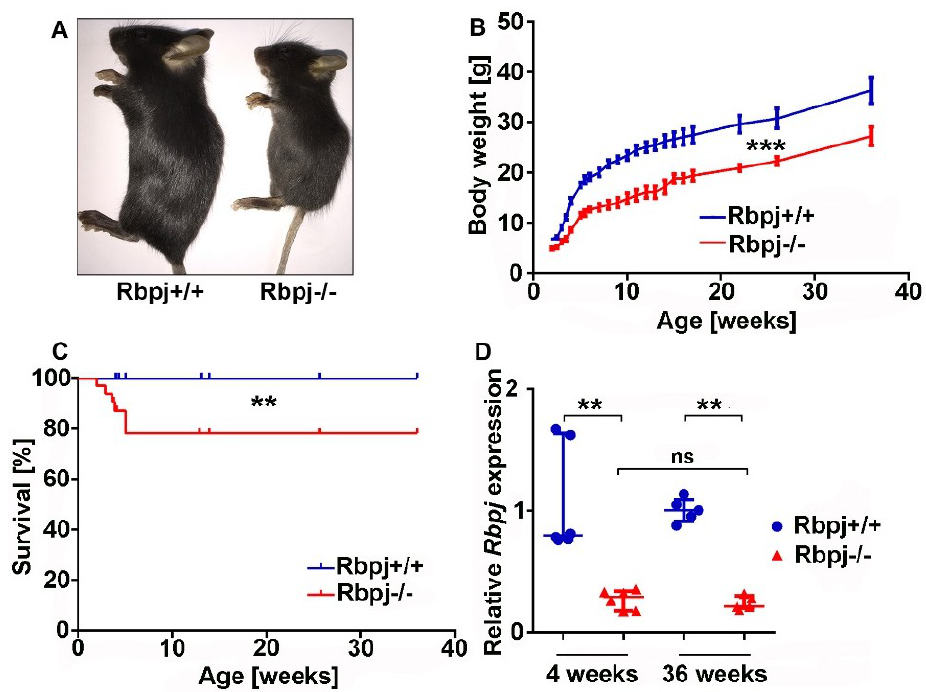
Figure 1. Liver-specific Rbpj deletion results in reduced body size and impaired survival. ( A ) Macroscopic photographs of Rbpj +/+ and Rbpj − / − mice at 4 weeks of age ( n = 5–6). ( B ) Body weight curve of Rbpj +/+ and Rbpj − / − mice, Rbpj − / − mice show persistent lower body weight ( n = 31–32; *** p ≤ 0.0001, Pearson coefficient correlation (Two tailed)). ( C ) Survival curve, Rbpj − / − mice show impaired survival until 5 weeks of age ( n = 32; ** p ≤ 0.01, Log-rank (Mantel–Cox) test). ( D ) Relative mRNA expression levels of Rbpj in 4- and 36-week-old mice. Scatter dot plots showed reduced Rbpj expression level in Rbpj − / − mice compared to Rbpj +/+ mice normalised to RNA polymerase II ( n = 5–6; ** p ≤ 0.01, ns = not significant; Mann–Whitney test (Two tailed)).